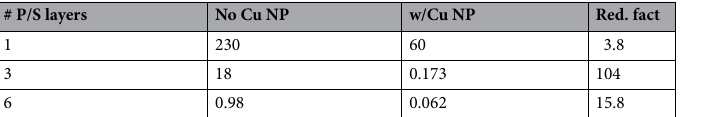
Table 3. R sq in units of kΩ for multiple coatings with and without Cu NP doping. The reduction factor (Red. Fact.) of R sq by the Cu NP is also